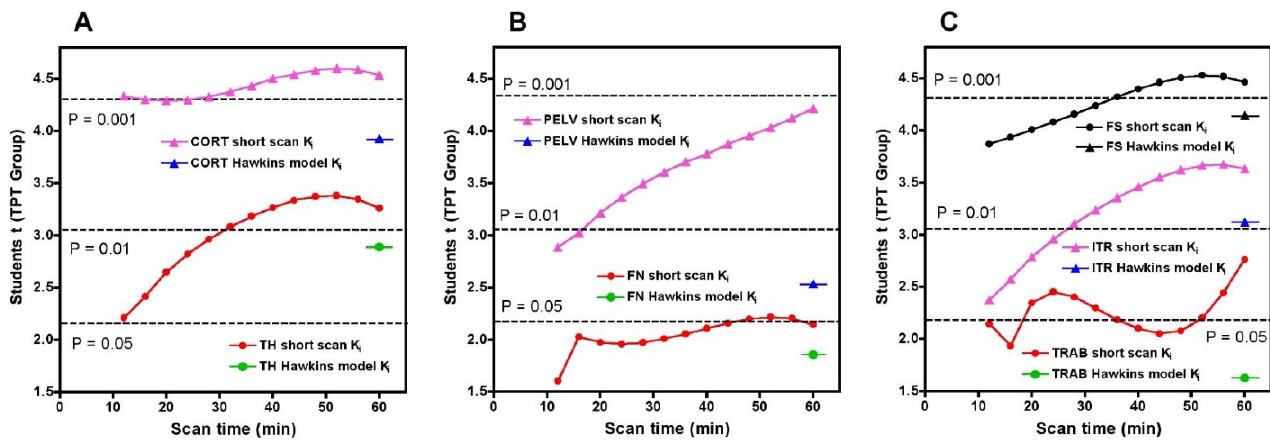
Figure 5. Values of Student’s t for the changes in the short-scan measurements of Ki between baseline and 12-weeks in the TPT group for scan times between 12 and 60 min. Results are shown separately for each of the seven volumes of interest (VOI). ( A ) CORT: cortical bone VOI; TH: total hip VOI; ( B ) FN: femoral neck VOI; PELV: pelvis VOI; ( C ) FS: femoral shaft VOI; ITR: intertrochanteric VOI; TRAB: trabecular bone VOI. For each VOI, the value of Student’s t for the 60-min Hawkins model analysis is shown for co mparison. Dotted lines indicate values of Student’s t for p = 0.05, p = 0.01 and p = 0.001.